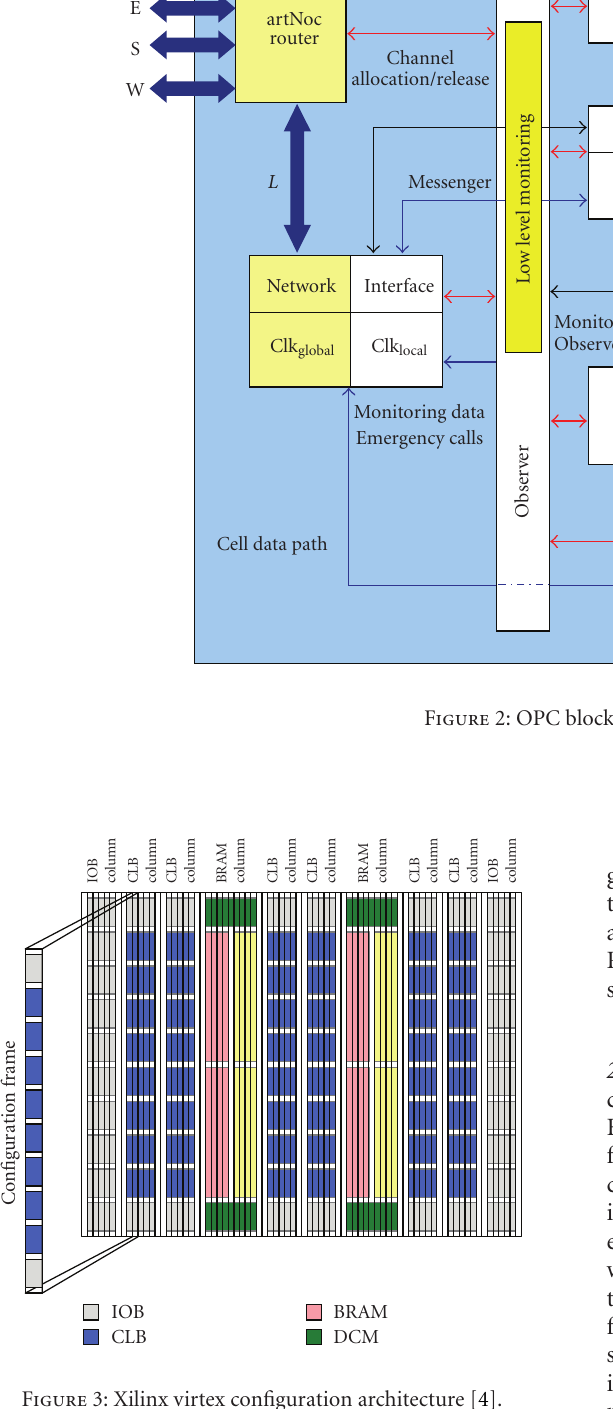
clock distribution bu ff er or look-up tables, which are not covered by the addressing scheme. A direct addressing of these units may be